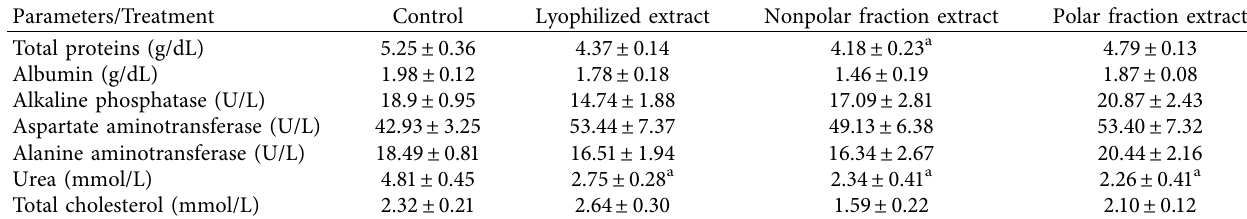
Table 3: Effects of three different date pit extracts on some plasma parameters in